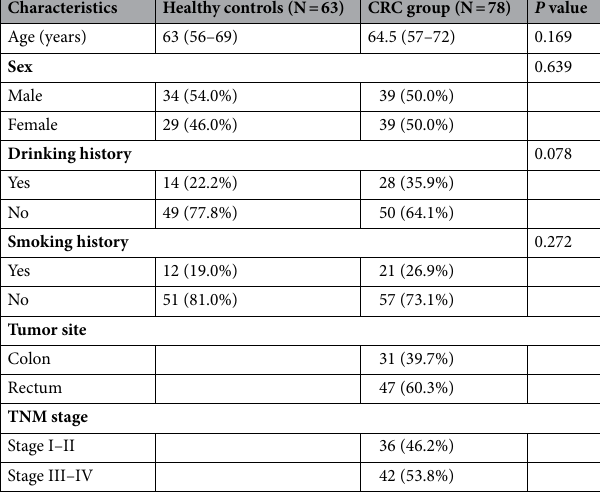
patients who met the inclusion criteria for the CRC group and 28 healthy controls were studied for interferon- gamma (INF-γ) secretion function of T lymphocyte subsets. T lymphocyte subsets in the healthy control and CRC groups. Supplementary Table S1 lists the proportions and absolute counts of T lymphocyte subsets in the healthy control and CRC groups. Compared with those in the healthy control group, double-negative T (DNT) lymphocytes (% of T cells) were significantly lower in the CRC group (4.0 [2.4–6.5] vs. 5.5 [3.6–7.6], P = 0.018), whereas CD8 + CD38 + activated T cells (% of Tc) were significantly higher (10.3 [6.6–16.6] vs. 5.9 [4.6–10.5], P < 0.001) (Fig. 1A). Supplementary Fig. S2a shows the differences in the distribution of T cell subsets in the healthy control and CRC groups. When the absolute counts of subsets were compared between the healthy control and CRC groups, T cells, namely cytotoxic T cells (Tc) (273.2 [212.2–399.6] vs. 380.4 [296.7–498.9], P < 0.001); Th (549.2 [461.8–696.3] vs. 649.0 [537.9–841.8], P = 0.008); DNT (36.8 [21.7–63.5] vs. 54.7 [41.8–106.4], P < 0.001); CD8 + naive T cells (TN) (38.8 [19.8–74.9] vs. 58.1 [32.5–78.4], P = 0.038); CD8 + central memory T cells (TCM) (17.4 [9.1–28.3] vs. 25.3 [16.0–35.5], P = 0.003); CD8 + effector memory T cells (TEM) (68.3 [44.5–108.3] vs. 103.5 [61.7–146.6],